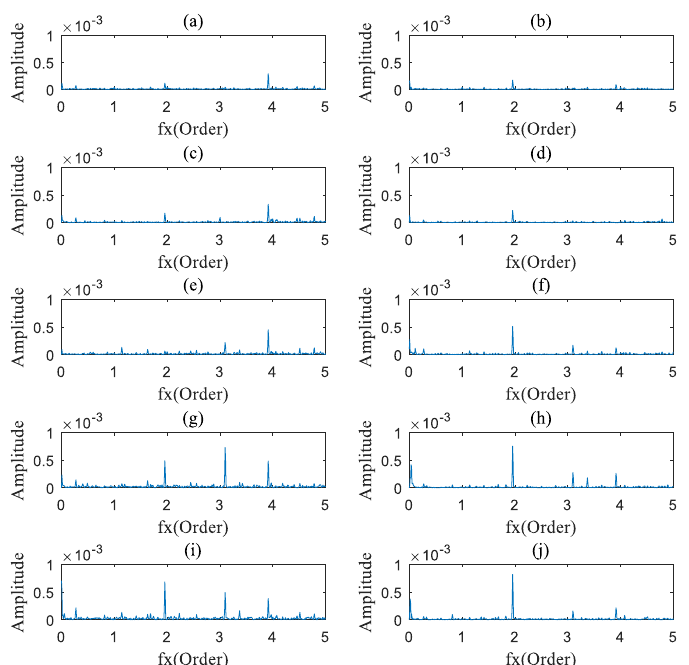
Figure 11. The characteristic slice under 30% rated speed conditions: ( a ) Healthy PG at 0% rated load; ( b ) Pitting fault on sun gear of PG at 0% rated load; ( c ) Healthy PG at 25% rated load; ( d ) Pitting fault on sun gear of PG at 25% rated load; ( e ) Healthy PG at 50% rated load; ( f ) Pitting fault on sun gear of PG at 50% rated load; ( g ) Healthy PG at 75% rated load; ( h ) Pitting fault on sun gear of PG at 75% rated load; ( i ) Healthy PG at 90% rated load; ( j ) Pitting fault on sun gear of PG at 90% rated load.